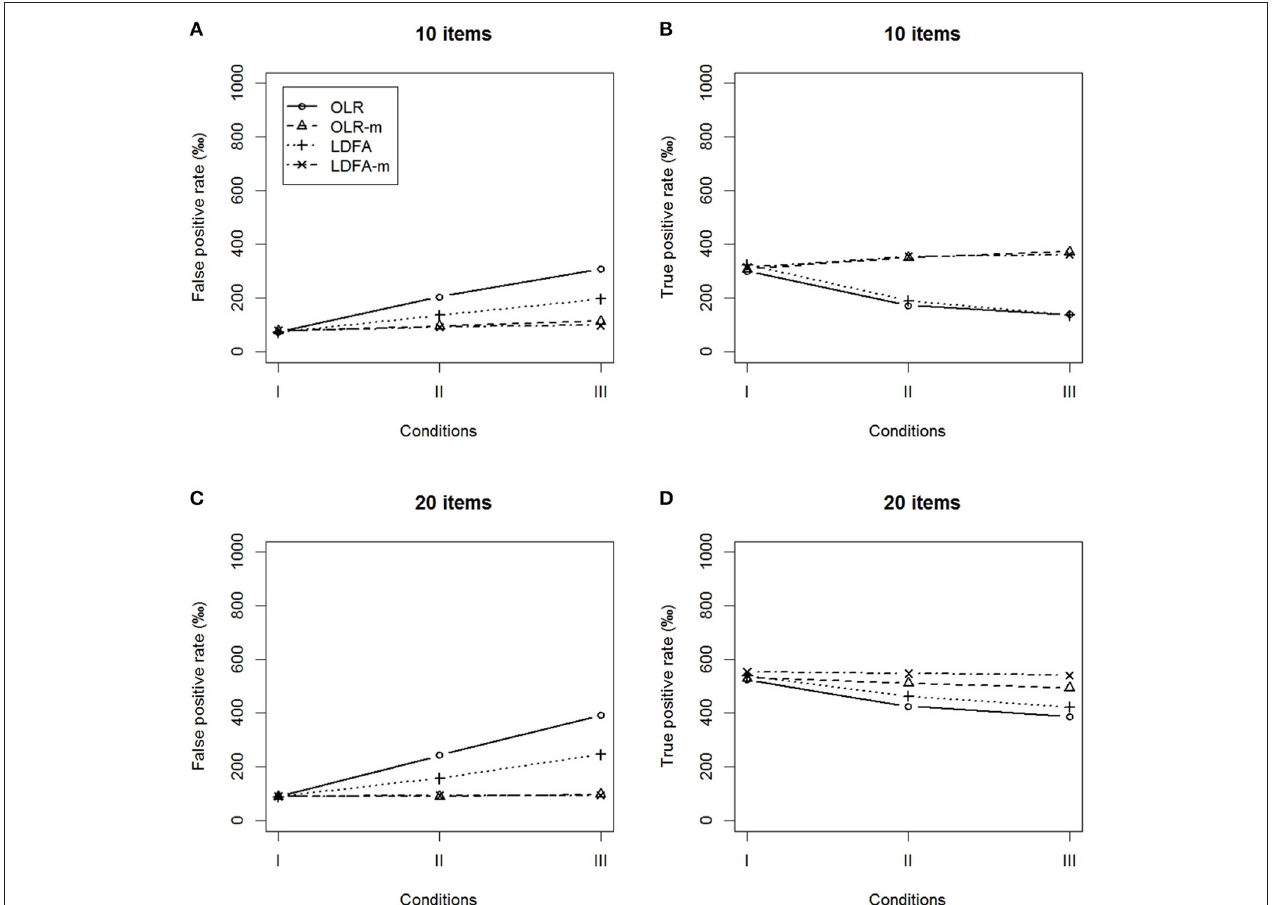
FIGURE 3 | False positive rates and true positive rates under the conditions of unbalanced DIF. (A,B) 10 items and (C,D) 20 items.